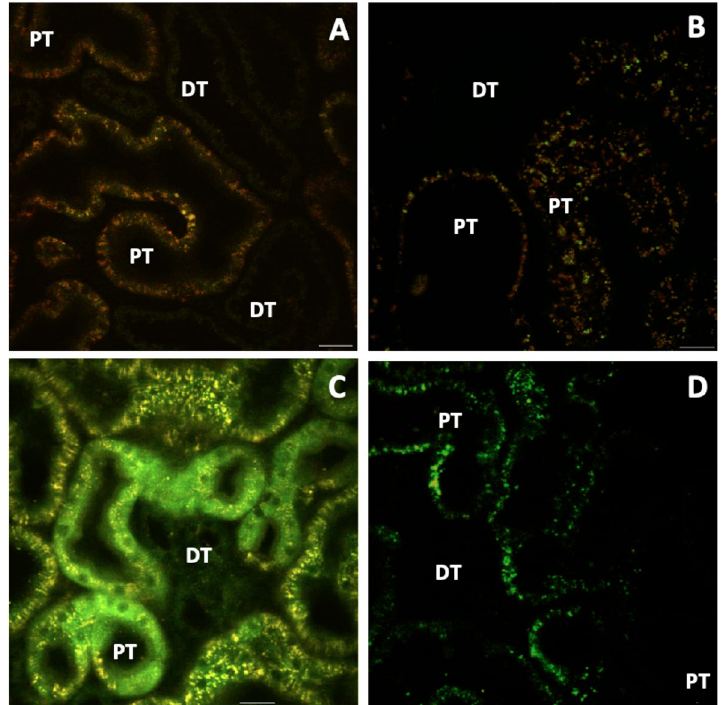
Figure 4. Extensive alterations to tubular structure that occurred after one hour of reperfusion. Intravital two- photon micrographs taken with a 60X objective show the effects of severe IRI in vivo. Animals that received sham injuries maintained intact tubular structure ( A and C ). ( A ) was obtained from an animal that did not receive HGD (group 1), while ( C ) (which displays the actin-rich brush border) was obtained from an